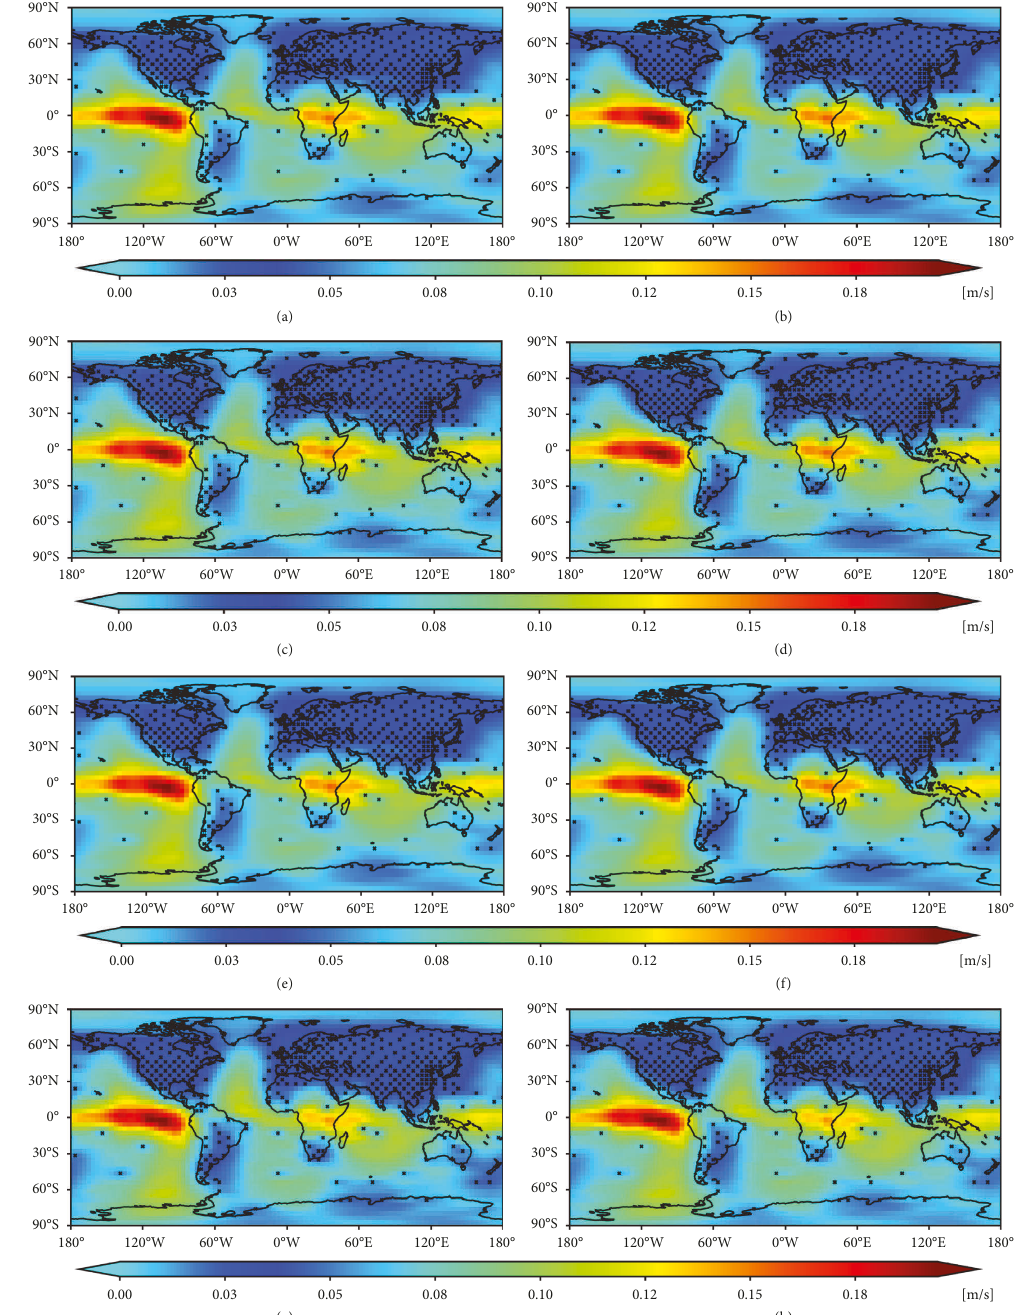
Figure 7: The spatial distributions of the time-mean analysis spread instead of analysis RMSEs for zonal wind from 0000UTC 1 March 1982 to 0000 UTC 1 April 1982 with different ensemble sizes, and (a), (b) ensemble size � 75; (c), (d) ensemble size � 100; (e), (f) ensemble size � 125; (g), (h) ensemble size � 200. (a), (c), (e), and (g) refer to the analysis result from the CL, and (b), (d), (f), and (h) refer to the analysis result from the